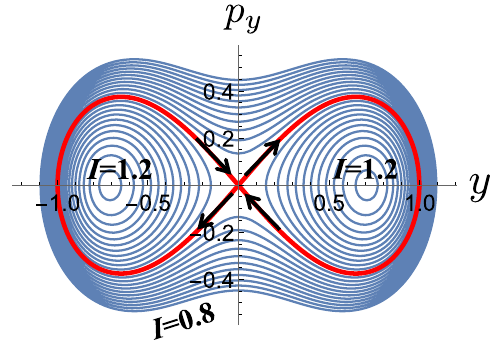
FIG. 9. Poincar´e section illustrating the critical level set ð H; I Þ ¼ ð 0 . 5 ; 1 Þ (red curve). Intersections of several level sets of F with the surface defined by H ¼ 0 . 5 , x ¼ 0 are shown for τ ¼ − 0 . 4 . Curves in blue correspond to distinct values of I ranging from I ¼ 0 . 8 to I ¼ 1 . 2 . The critical level set contains an FIG. 8. The orbit obtained by numerical tracking of initial 0 and ð x; y Þ ¼ ð 0 . 7 ; 0 . 3 Þ for τ ¼ − 0 . 4 is p unstable periodic orbit, intersecting the surface at the condition p x ¼ y ¼ shown together with the upper component of the corresponding invariant level set, which is defined by ð H; I Þ ¼ ð 0 . 39 ; 0 . 86 Þ . The boundary of the level set appears in blue. Compare Fig. 7(b).